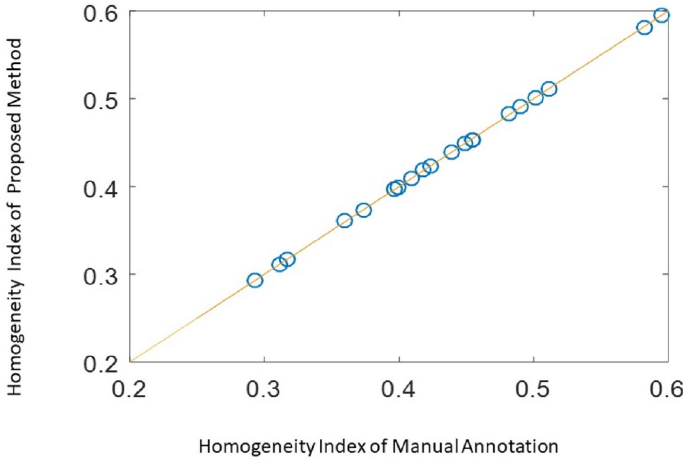
Figure 9. Validity evaluation of the method to calculate the distribution quality index of the rice clusters.